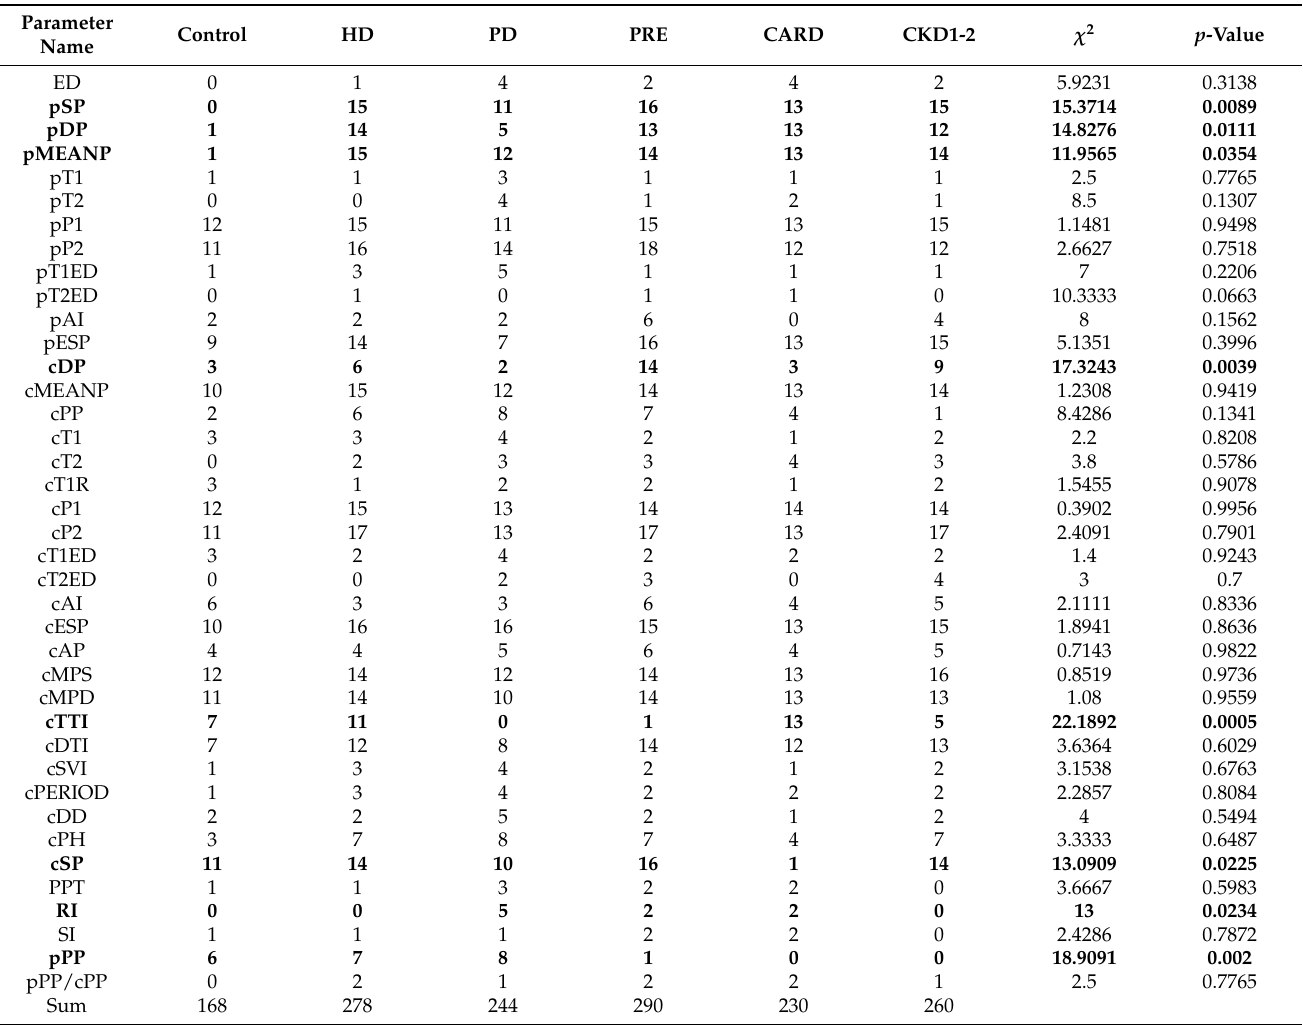
Table 4. Node degree distribution in correlation graphs with additional χ 2 test results for every parameter. Strong differences are marked with bold